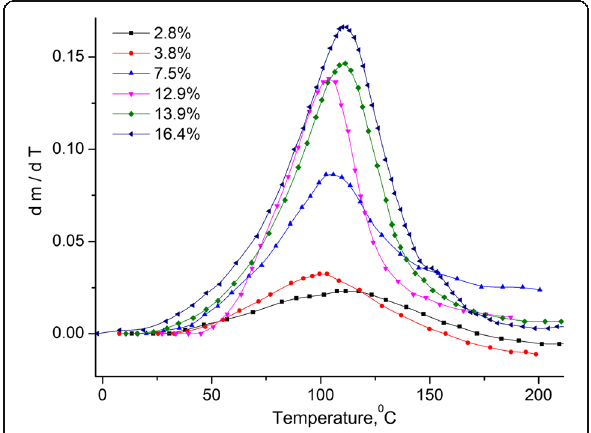
Fig. 2 Temperature dependence of the derivative of mass change of MCC. Temperature dependence of the derivative of mass change dm / dT of MCC samples with different water content